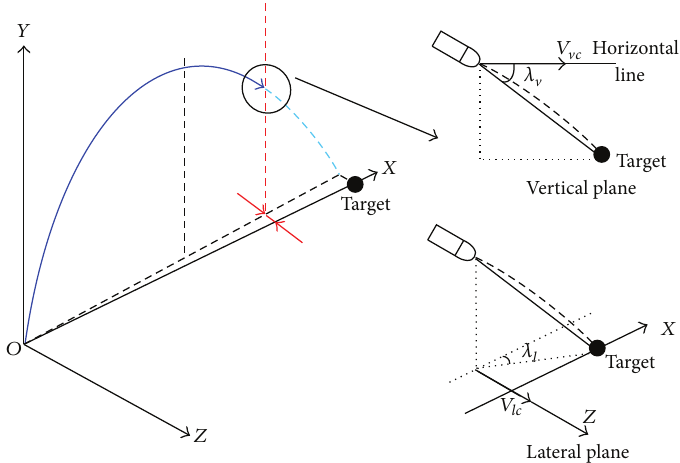
Figure 12: Sketch map of proportional guidance law in the descending segment.